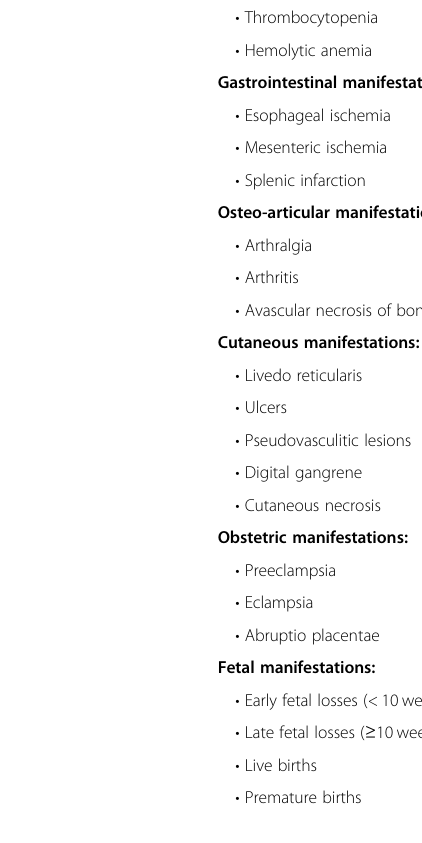
Table 2 Clinical characteristics of antiphospholipid syndrome [6] Peripheral